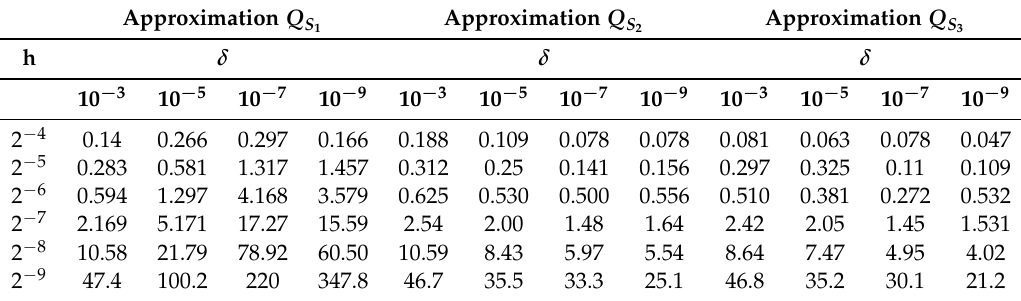
, Q S , Q S for different values of h and δ , tolerance = 10 − 6 . 2 3 1